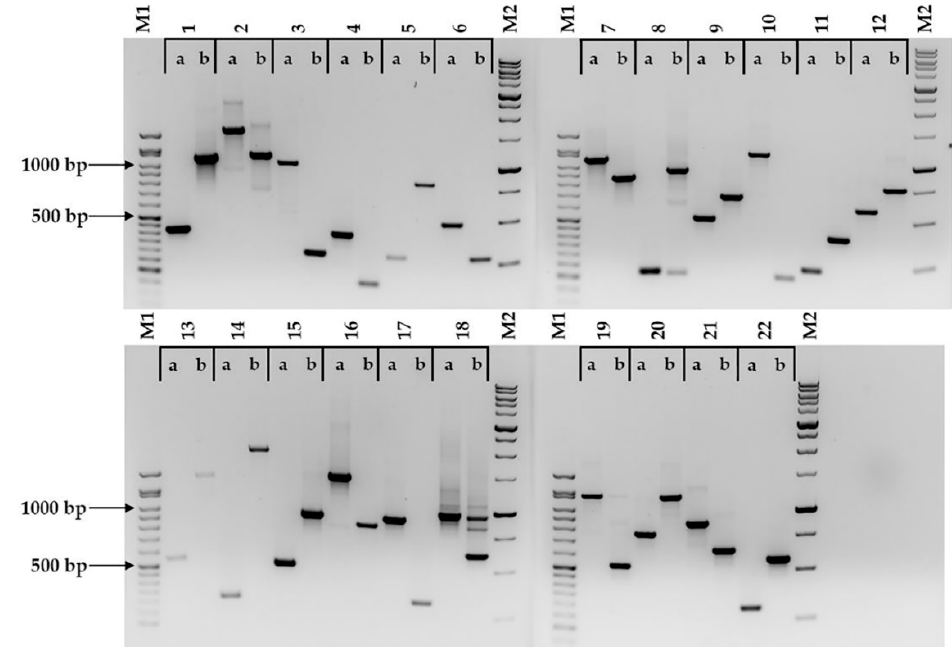
Figure 1. 22 markers (BdindelWSU_1 to BdindelWSU_22) that discriminate between the two closely related Brachypodium distachyon accessions Bd21 (a) and Bd21-3 (b). The amplicons were visualized on a 1.5% agarose gel stained with ethidium bromide. M1 represents the GoldBio ® 50 bp DNA ladder, and M2 represents the GoldBio ® 1 kb PLUS ™ DNA ladder.